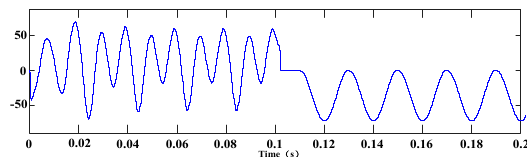
Figure 12. Arm current without fault blocking: ( a ) 𝑖 (cid:3022)(cid:3028) and ( b ) 𝑖 (cid:3013)(cid:3029) . Figure 11. Arm current i Ma without fault Figure 11. Arm current 𝑖 (cid:3014)(cid:3028) without fault blocking.